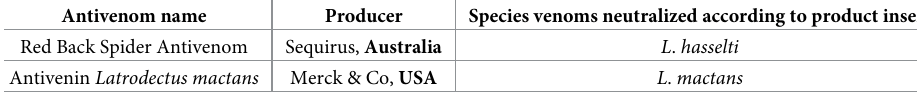
All of the listed antivenoms are produced as